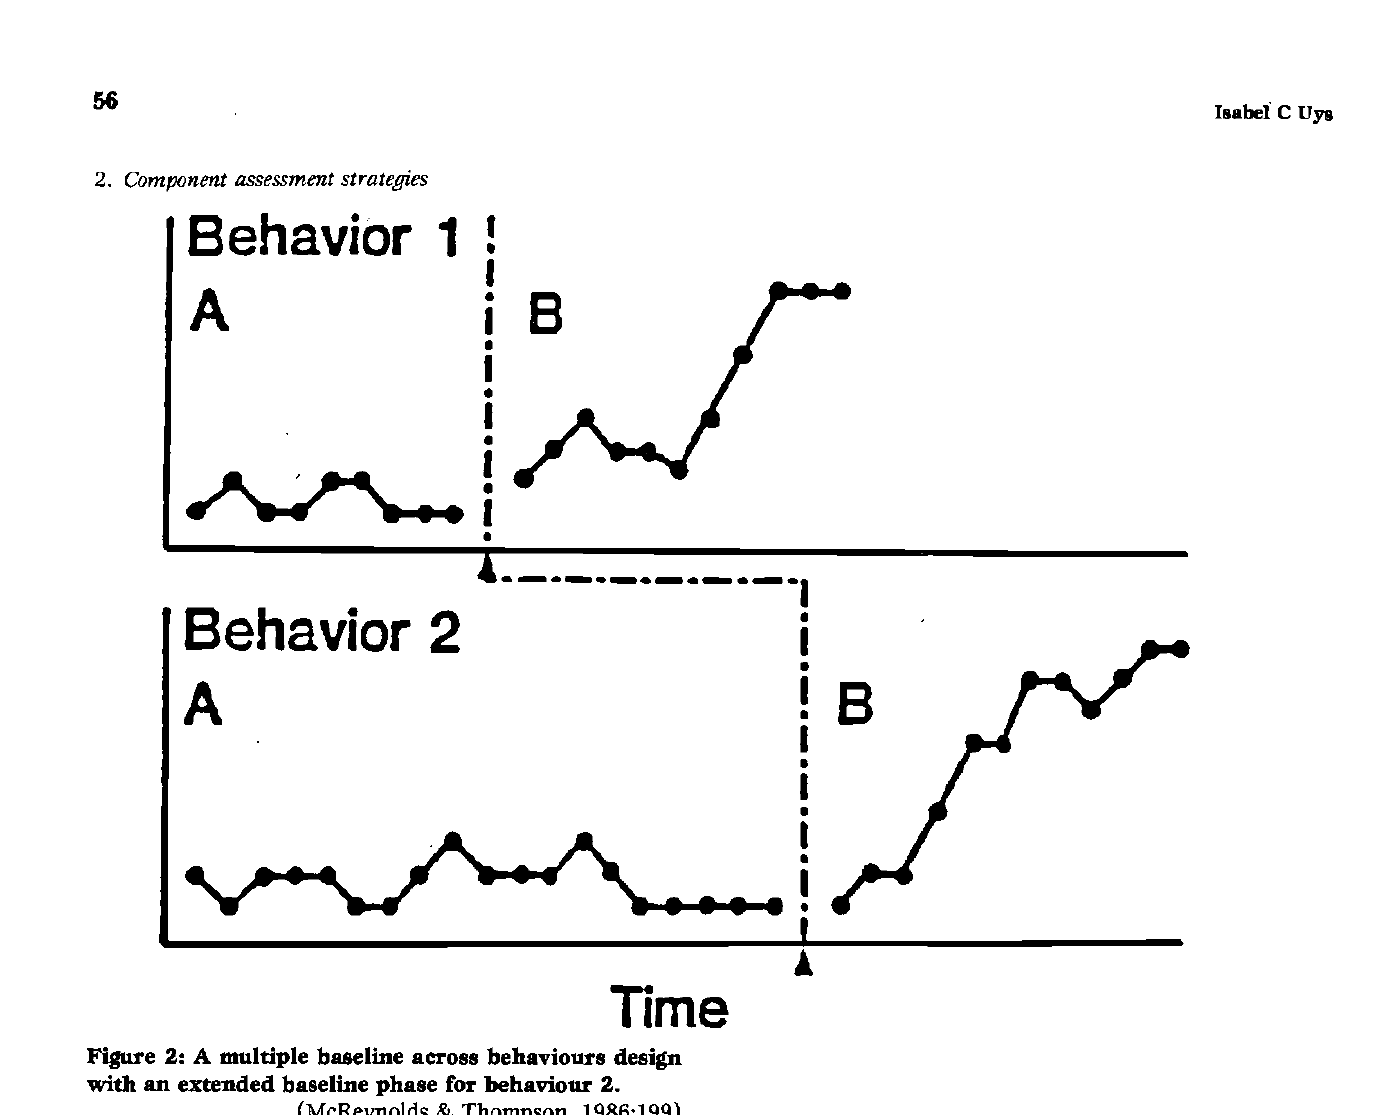
Figure 2: A multiple baseline across behaviours design with an extended baseline phase for behaviour 2.